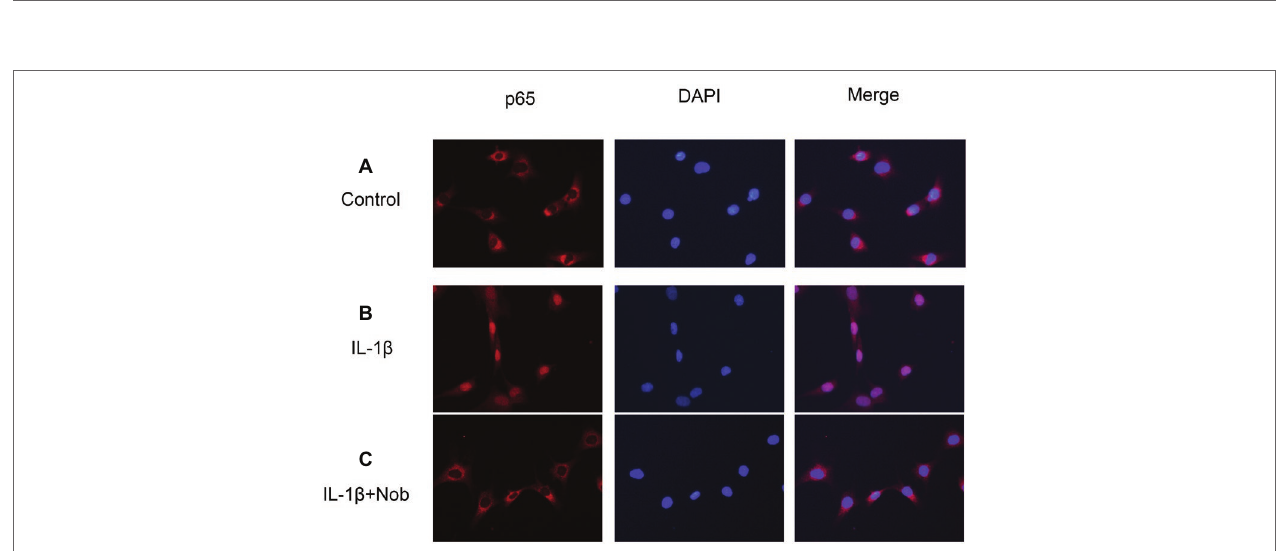
FIGURE 8 | Immunofluorescence staining of NF- κ B p65 protein in chondrocytes. Chondrocytes were untreated (A) , treated with IL-1 β alone (B) , or treated with IL-1 β and nobiletin (40 μM) (C) . In the untreated group, p65 was mainly restricted to the cytoplasm (A) . In the IL-1 β alone group, p65 was translocated to the nucleus (B) , a phenomenon inhibited by pretreatment with nobiletin (C) . All experiments were repeated three